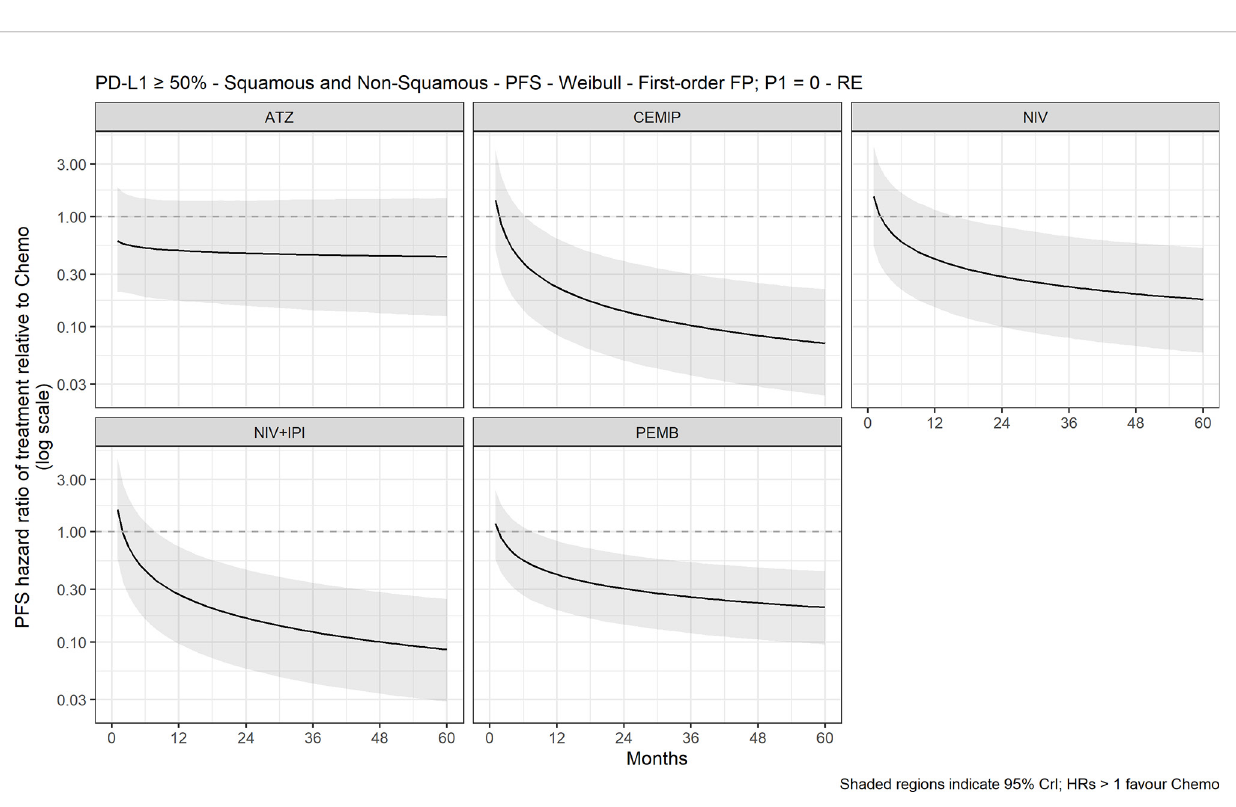
FIGURE 5 | Expected PFS HR over time for cancer immunotherapy versus chemotherapy with 95% CrI, mixed histology (60-month time horizon). ATZ, atezolizumab; CEMIP, cemiplimab; HR, hazard ratio; NIV, nivolumab; NIV+IPI, nivolumab plus ipilimumab; PD-L1, programmed death-ligand 1; PEMB, pembrolizumab; PFS, progression-free survival; FP, fractional polynomial; P1=0, Weibull; RE, random